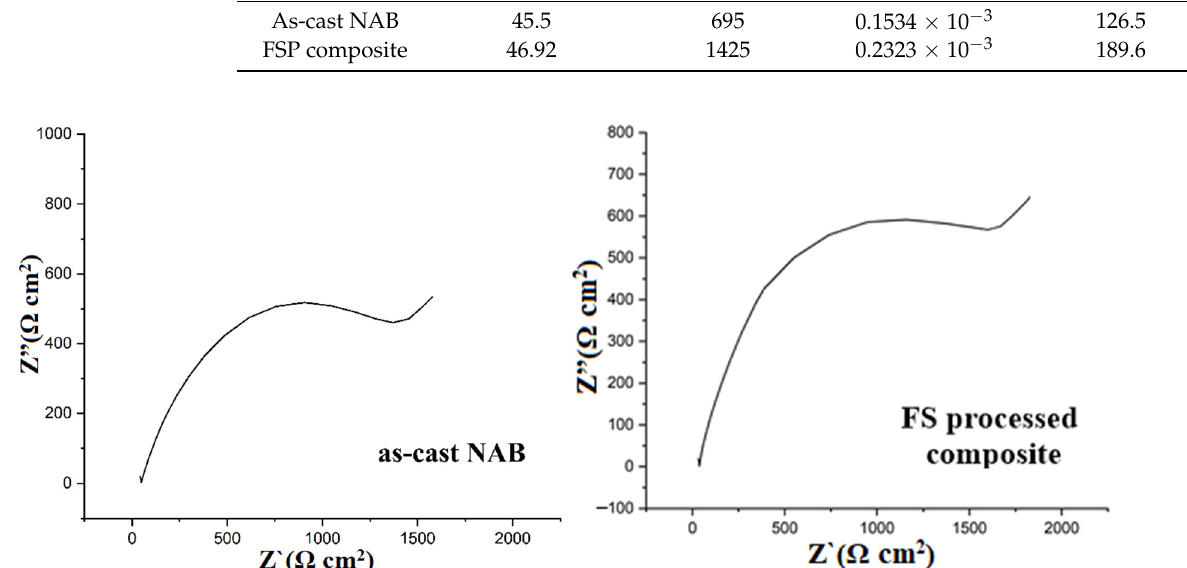
Figure 20. Nyquist plot for the as-cast NAB alloy and the FS-processed composite in 3.5 wt.% NaCl solution. Table 4. Fitted electrochemical parameters.